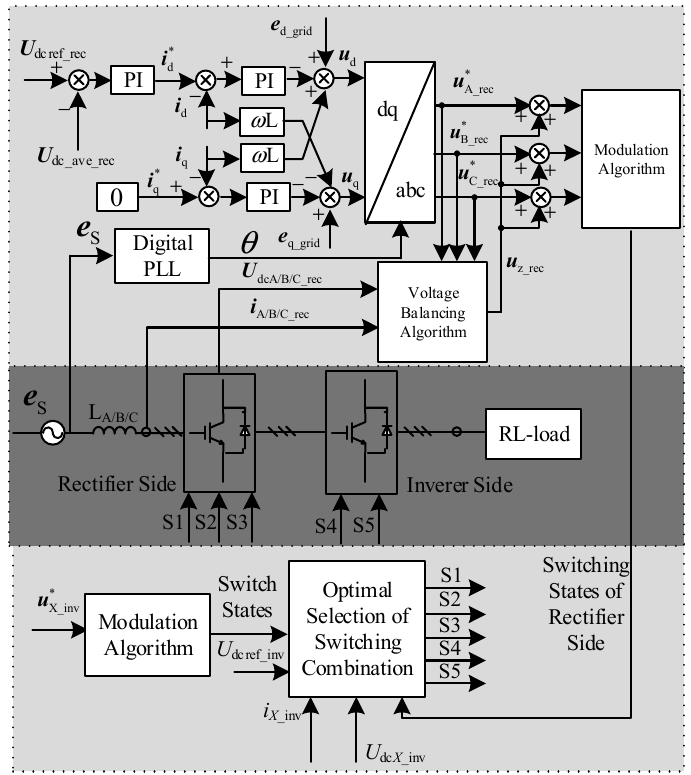
Figure 3. Control block diagram of the proposed multilevel converter.